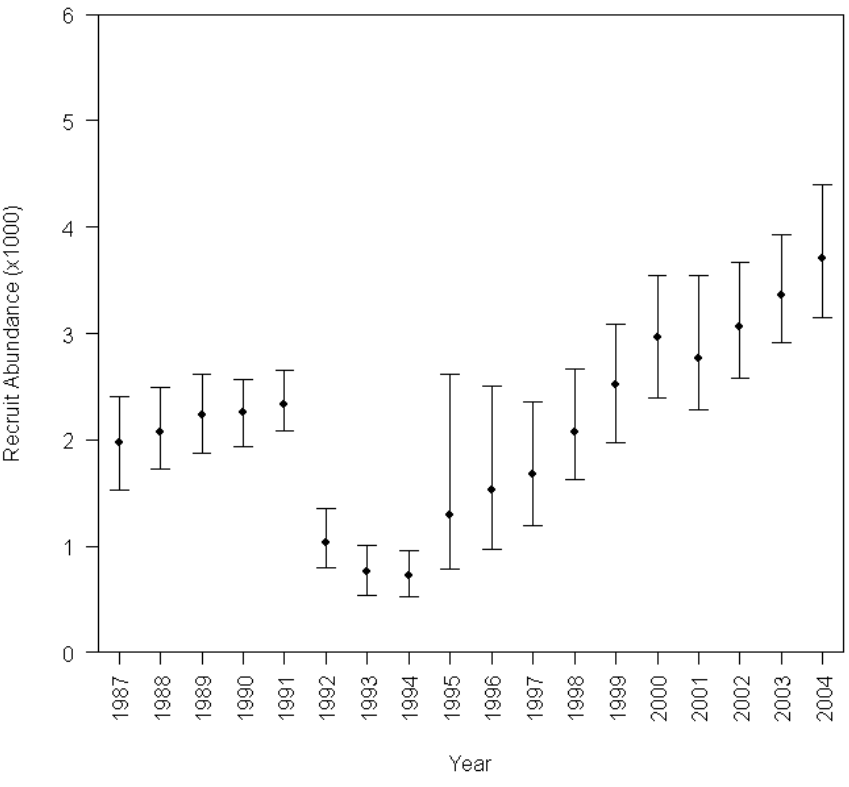
Figure A1.1. Estimated recruit abundance (age-2) of humpback chub in the Little Colorado River population of Grand Canyon National Park, from Coggins and Walters (2009). Estimates are from mark-recapture analysis of passive integrated transponder (PIT) tagging data (Coggins et al. 2006 a ). Error bars show effect on the estimates of aging error due to estimating fish ages from lengths since destructive sampling for structures that carry age information (e.g. otoliths) has typically not been allowed for this endangered